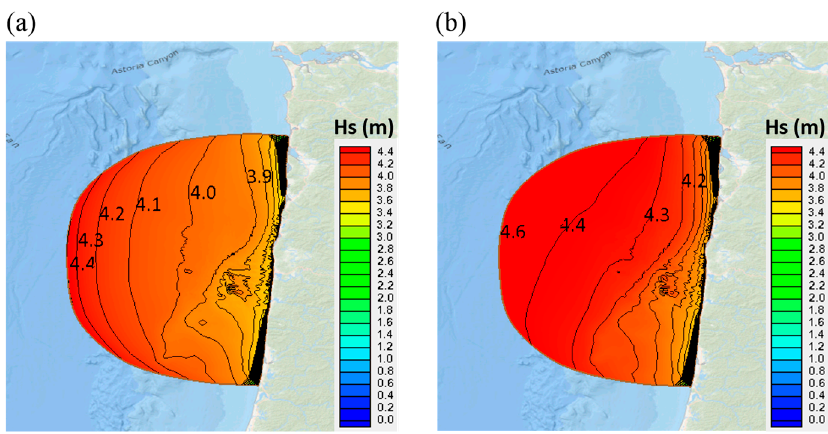
Figure 9. Modeled 2D significant wave height distributions with UnSWAN (L): ( a ) no wind—November average, 2009; ( b ) with wind—November average, 2009.